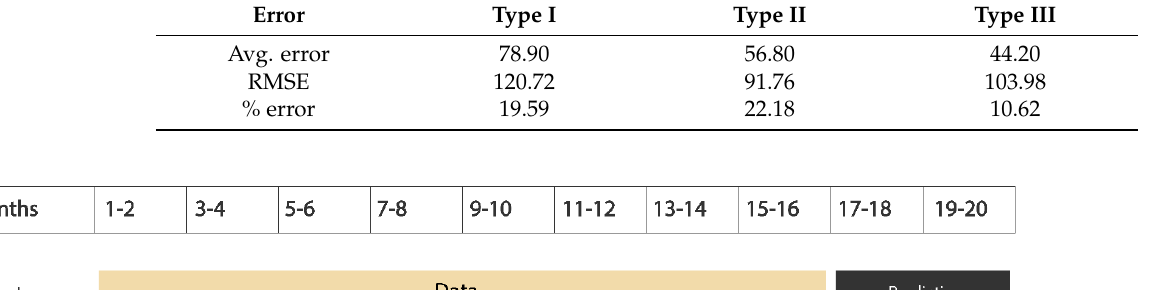
Table 2. Comparison of errors between prediction periods of type I, II, and III. Error